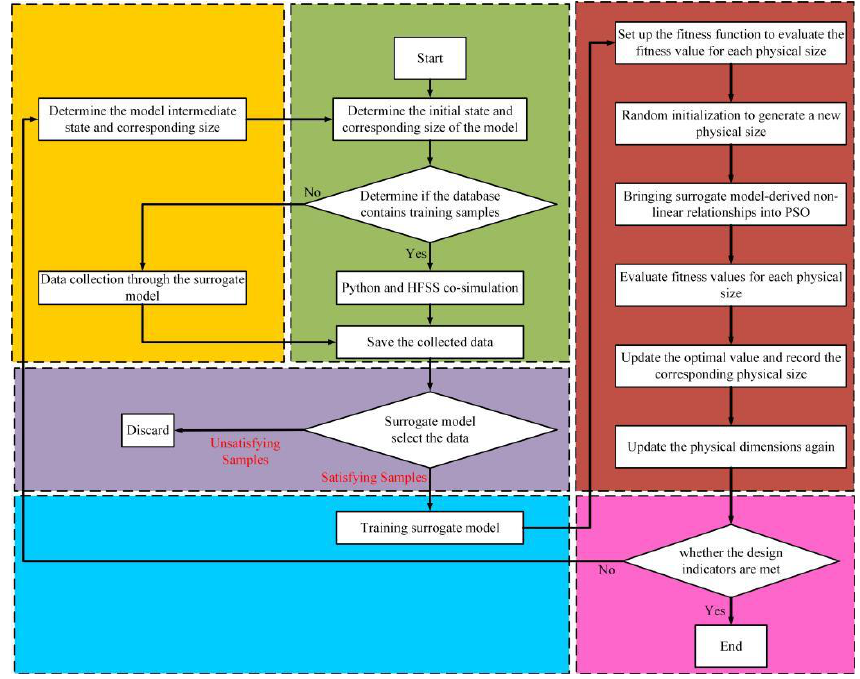
Figure 8. Internal process of the AOU-1D-CAE-APSO.